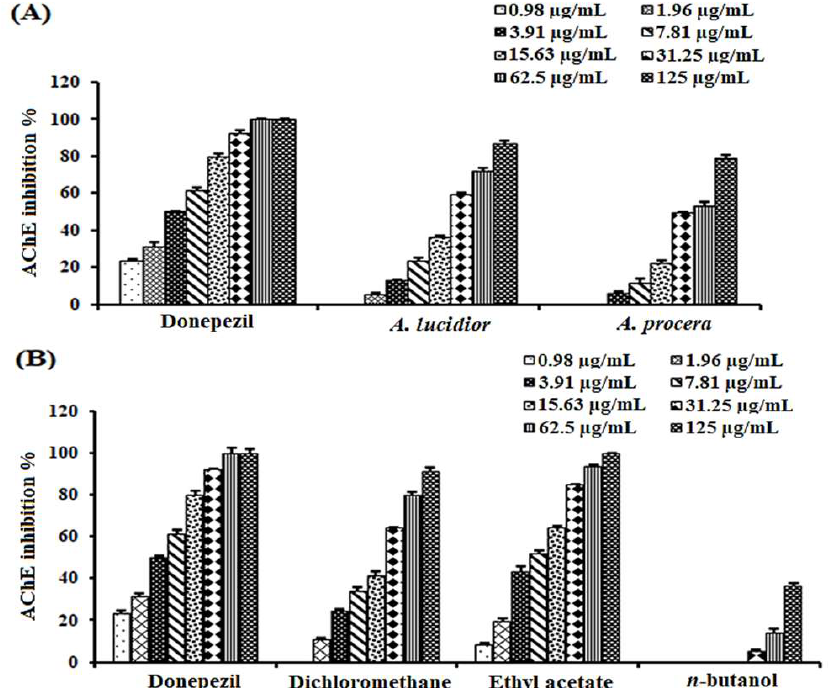
Figure 1. Acetylcholinesterase inhibitory activities of: ( A ) ethanolic extracts of A. lucidior and A. procera and ( B ) fractions of A. lucidior , compared to donepezil. Values are expressed as mean ± S.D. Table 1. Acetylcholinesterase inhibitory activity, represented by IC 50 of plant extracts and fractions. Extract/Fraction Ethanolic extract of A.